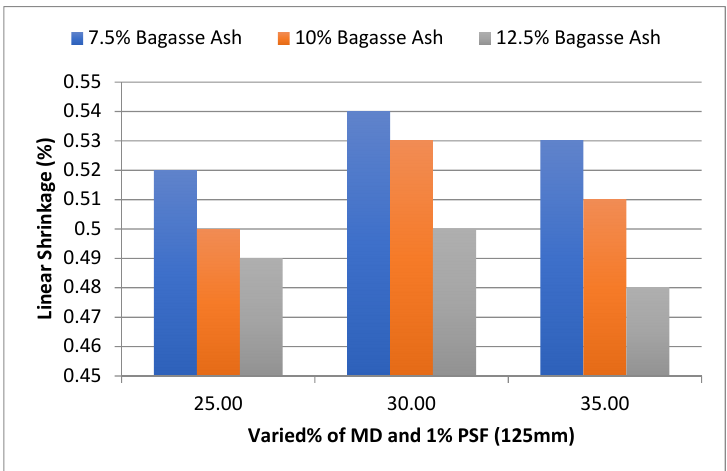
Figure 18. E ffect of MD and BA on linear shrinkage of block reinforced with 1% PS fiber (125 mm). However, it was observed from the experimental results that linear shrinkage showed a decrement with an increase in bagasse ash at constant marble dust content. It was found that linear shrinkage showed a similar trend with 1.2% PSF content too.